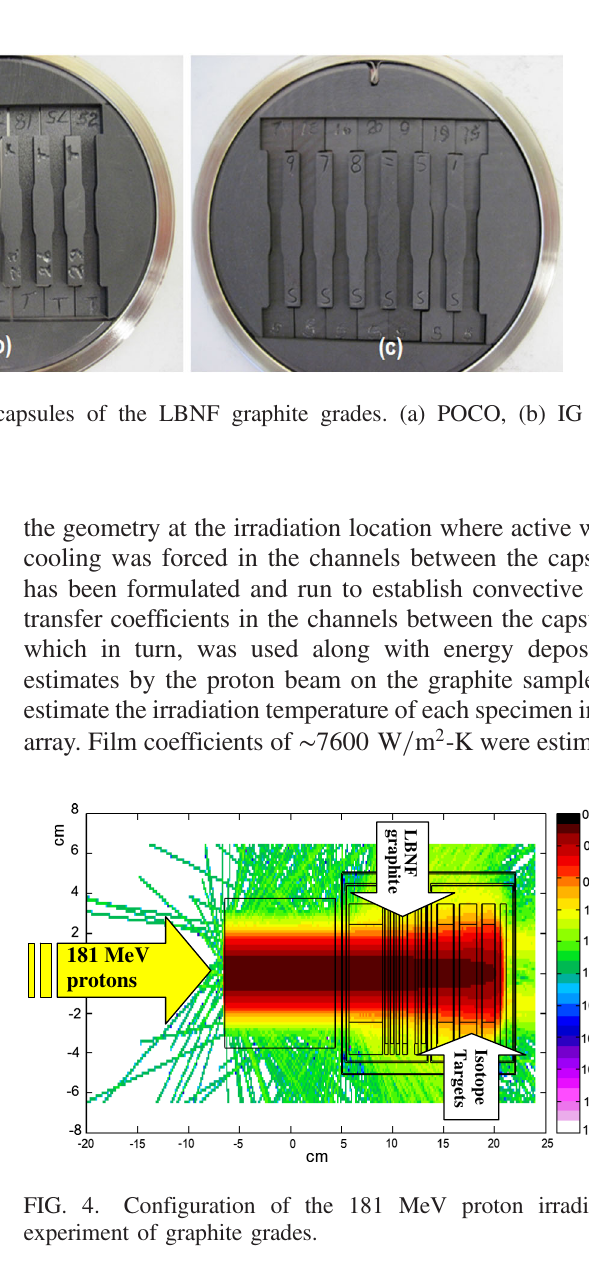
FIG. 2. Geometries of irradiated graphite specimens. Tensile sample (left) and CTE sample (right).